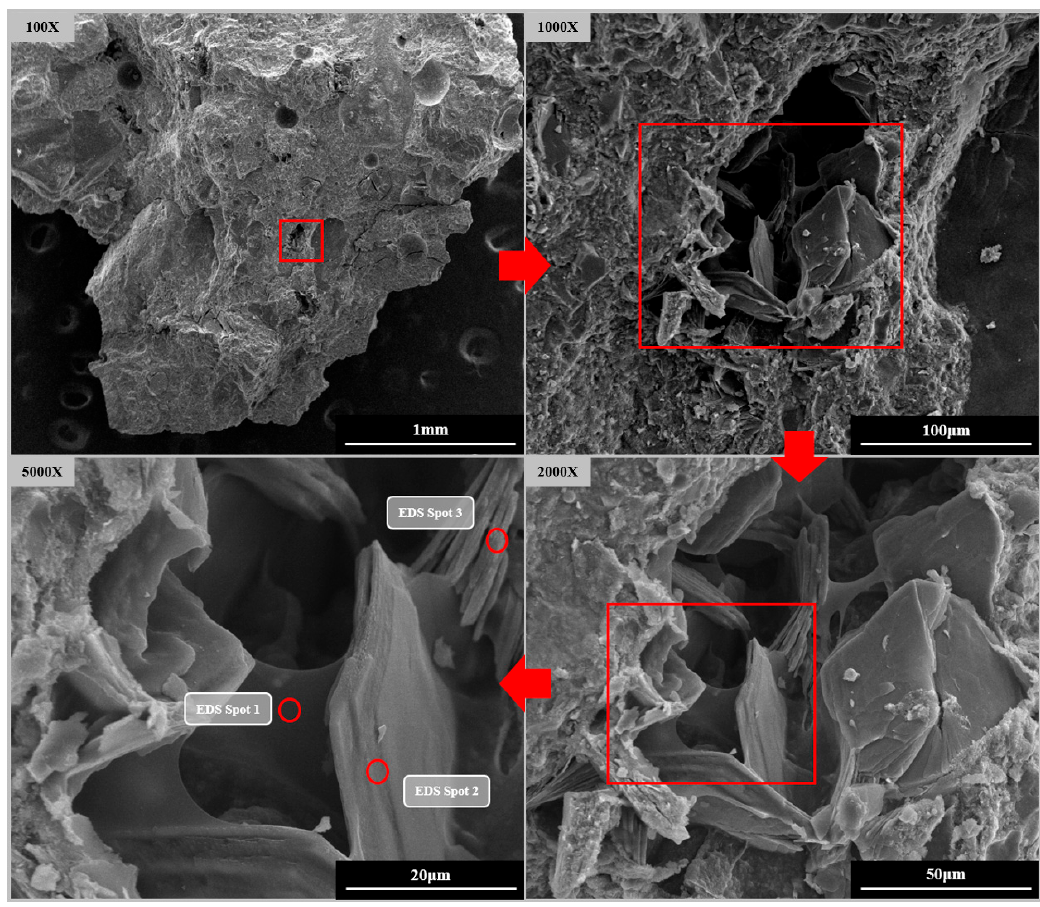
Figure 10. Pores formed by SAP in S2E2. Table 8. Elements at each point of S2E2 (wt%).